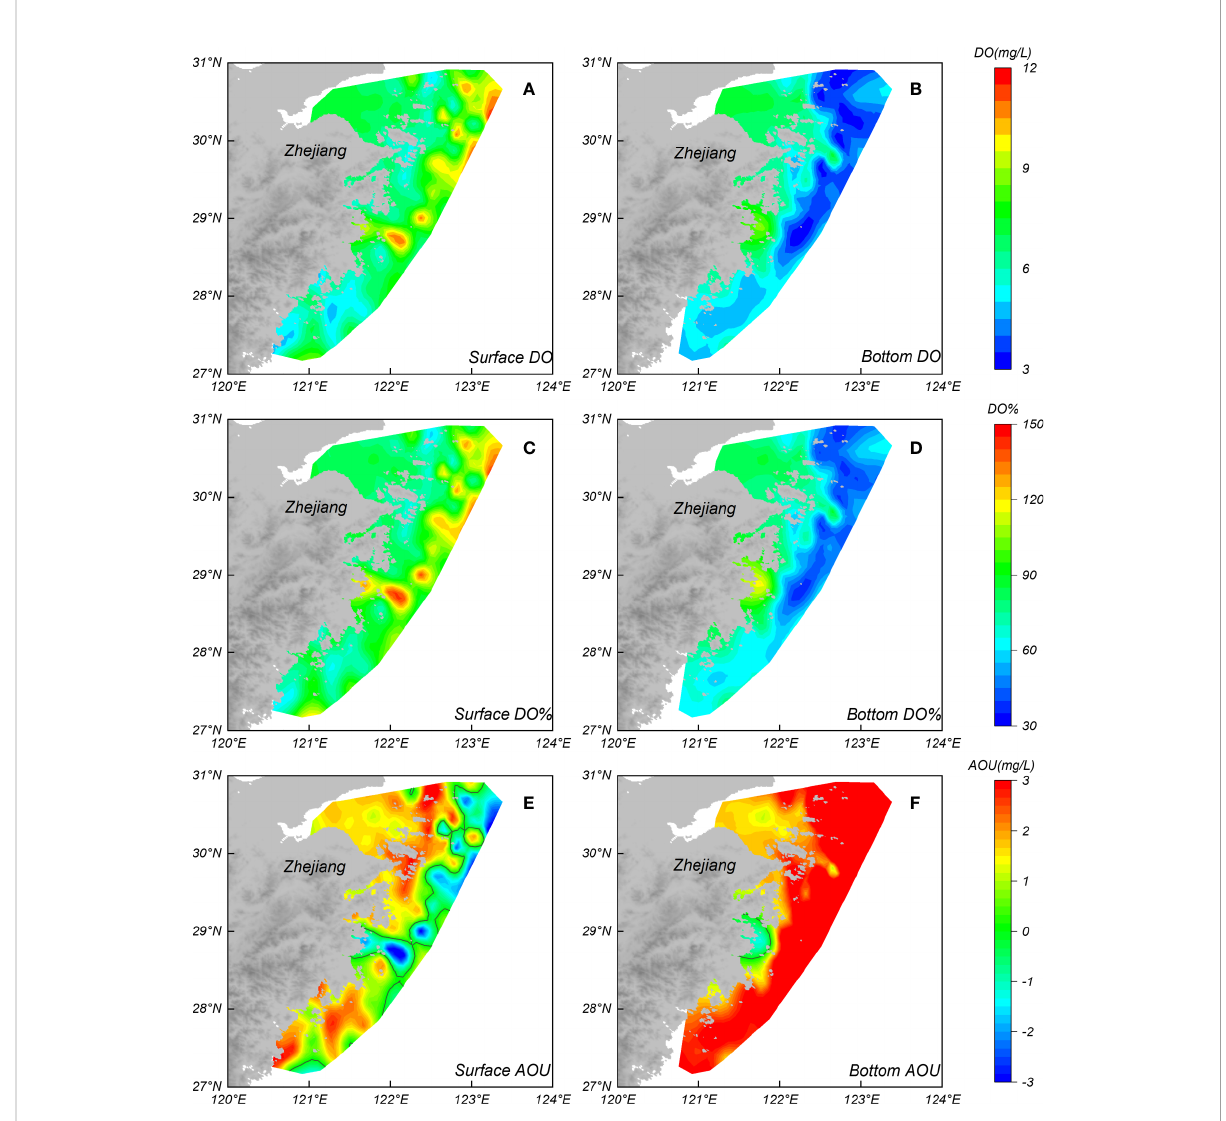
FIGURE 2 Horizontal distribution of DO concentration: surface (A) and bottom (B) , DO saturation: surface (C) and bottom (D) , AOU: surface (E) and bottom (F)